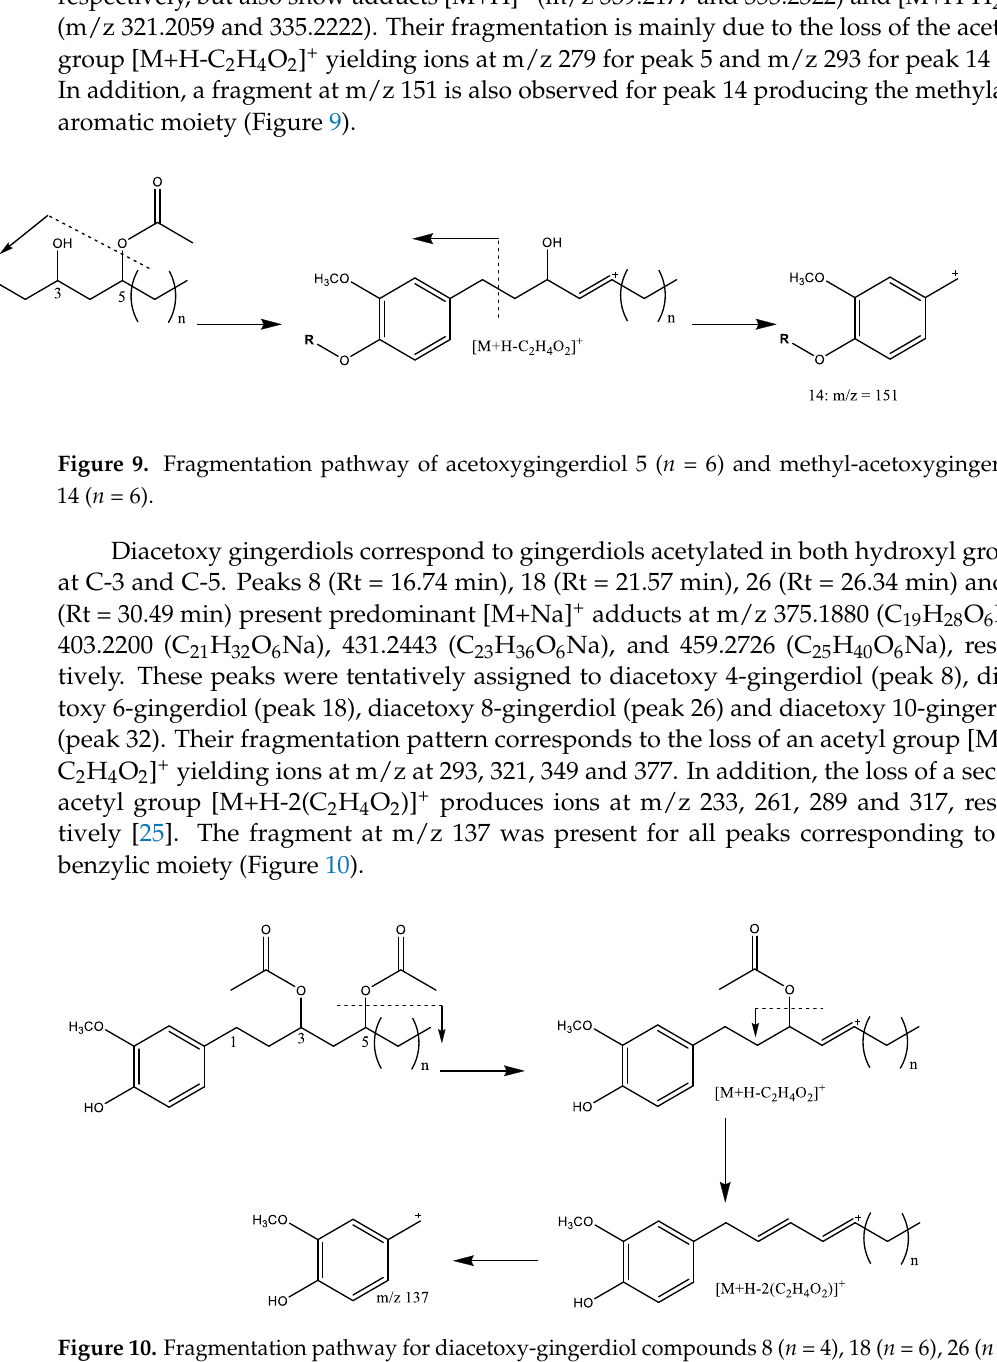
Figure 8. Fragmentation pathway for acetoxygingerol compounds 12 ( n = 6), 21 ( n = 8), 29 ( n = 10) and methylacetoxygingerol 16 ( n = 6).